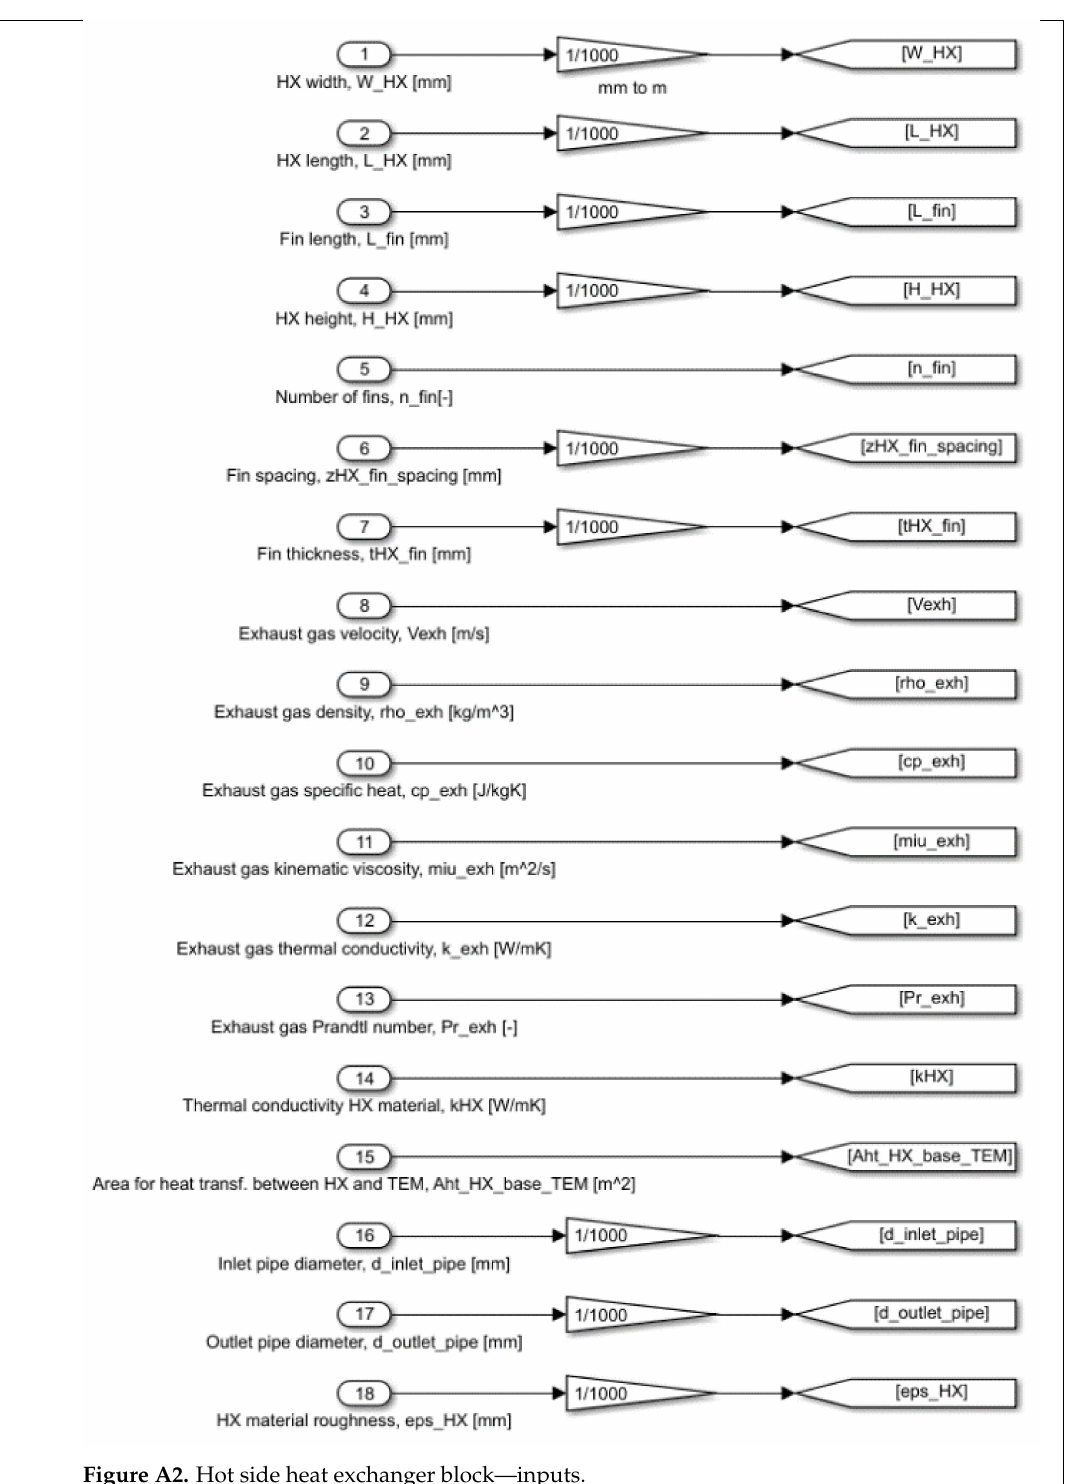
Figure A2. Hot side heat exchanger